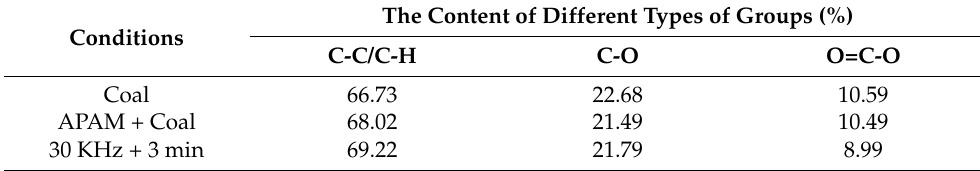
Table 3. Content of groups on the slurry surface under different